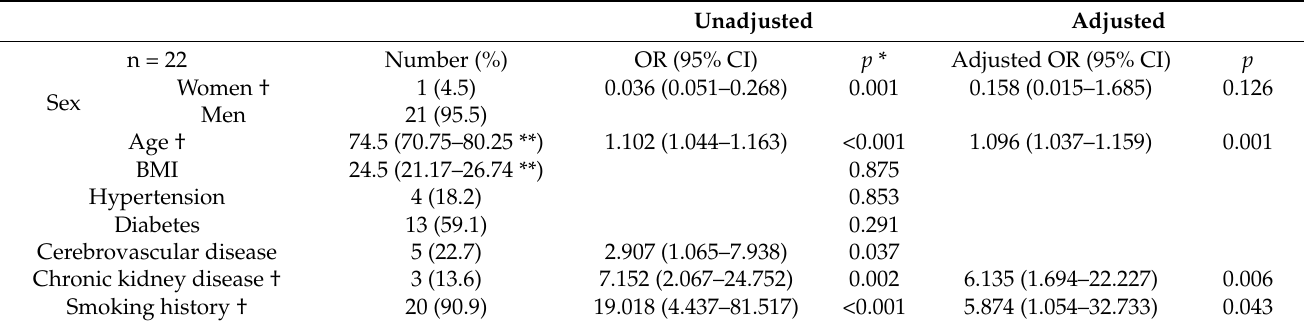
Table 3. Underlying conditions in the Korean participants with abdominal aortic aneurysm.